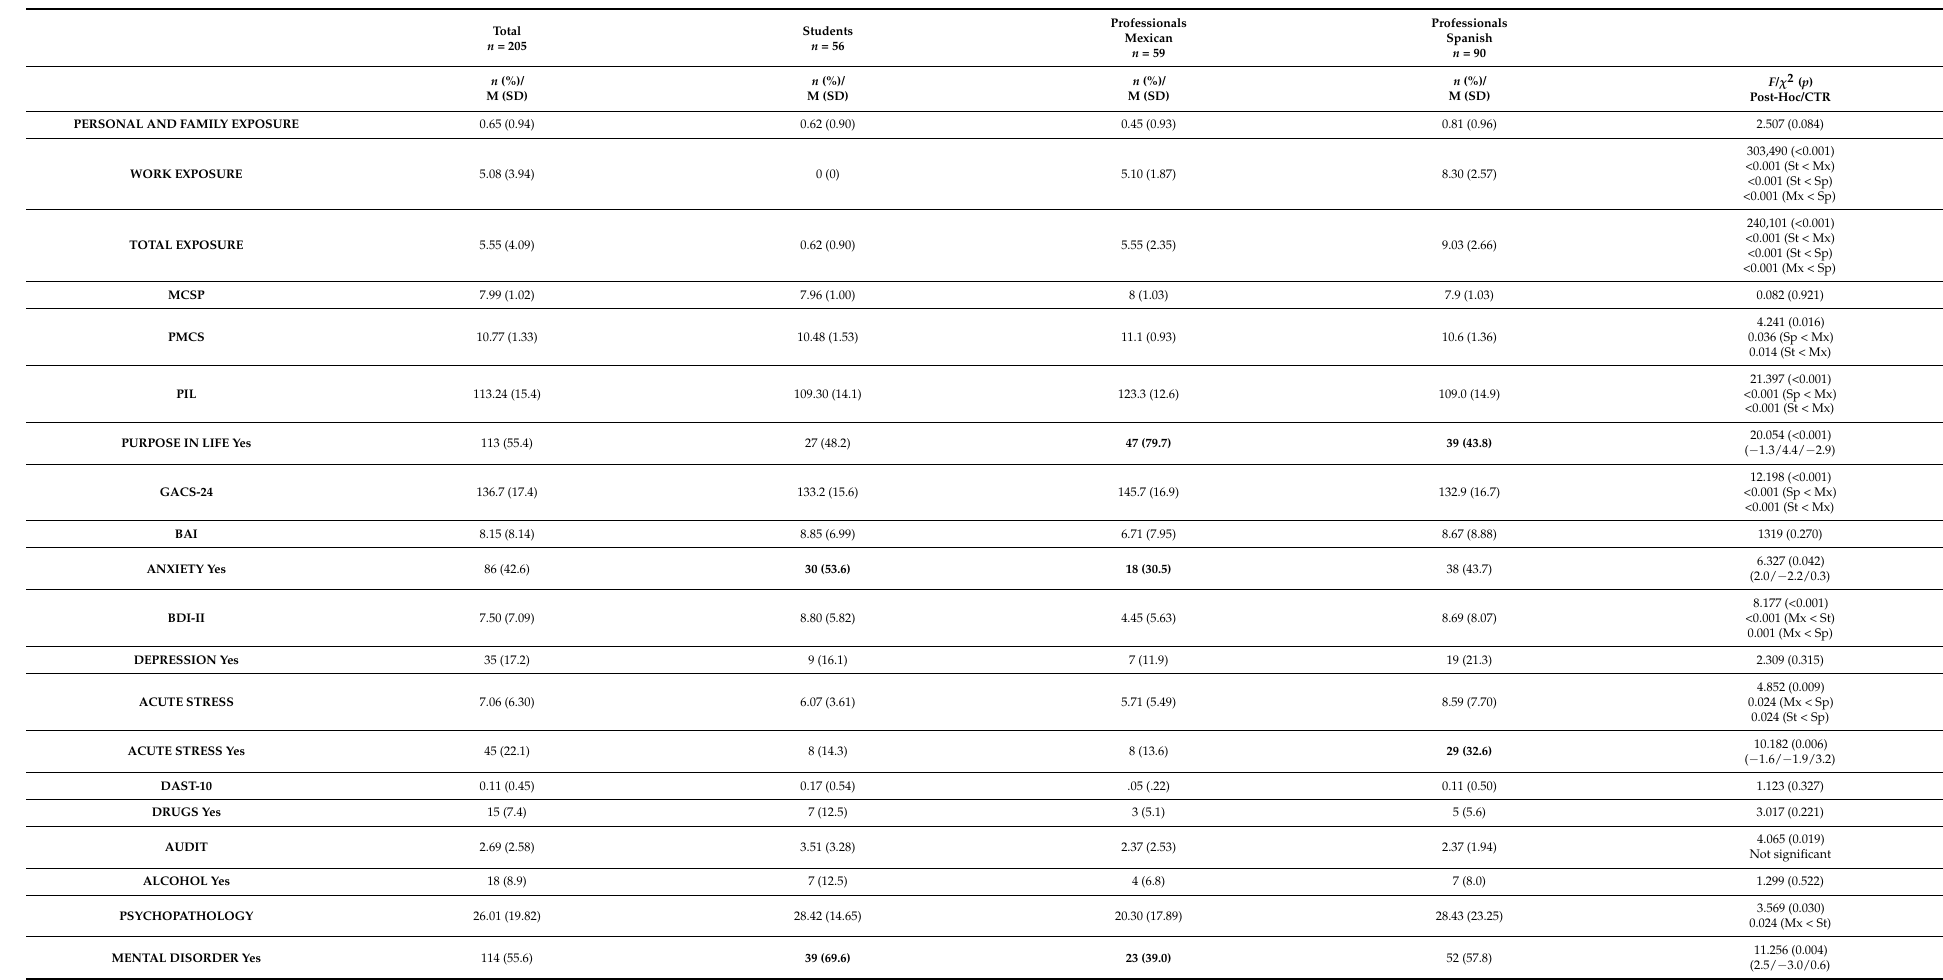
Table 2. Scores in the independent, modulating, and dependent variables and differences between the